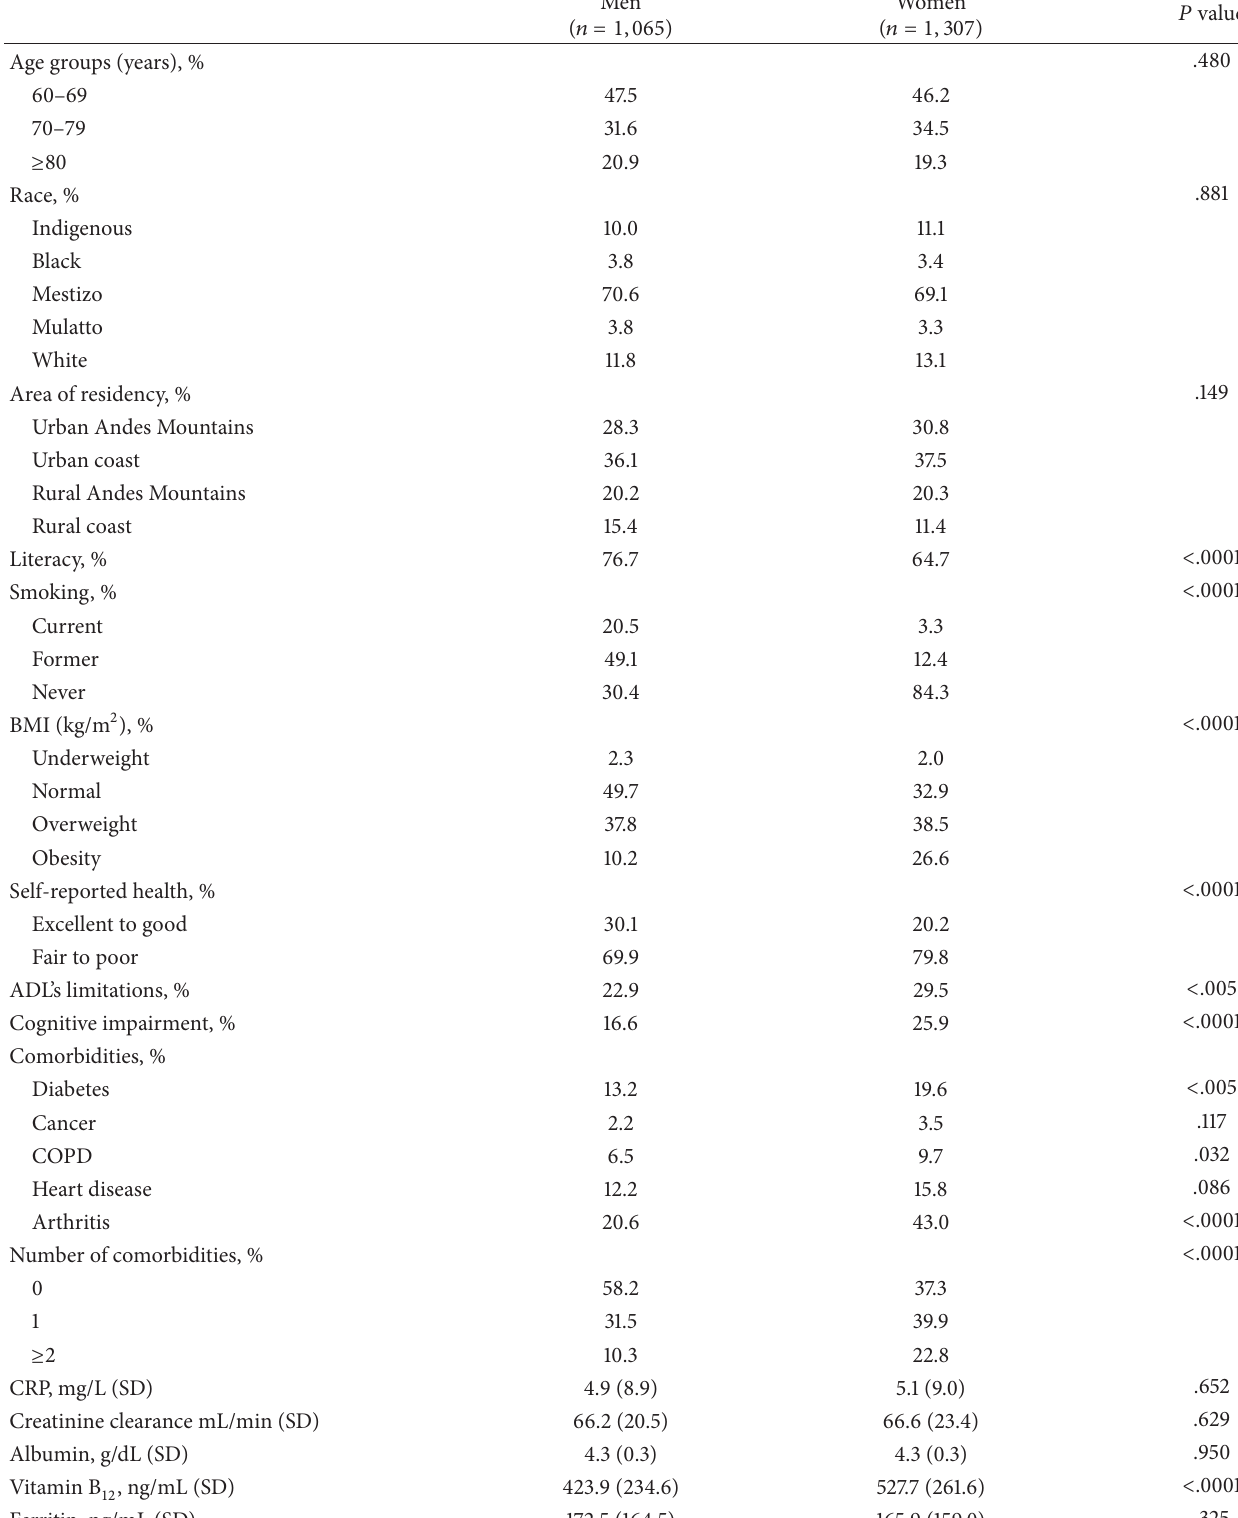
Table 1: Demographic and health characteristics of participants in the SABE